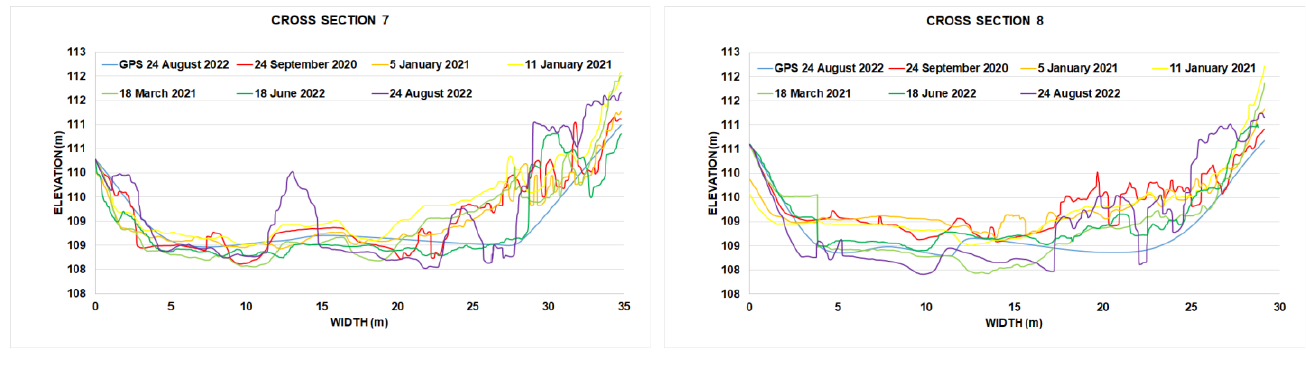
Figure 8. The produced profile of the cross-sections developed by the six UAV flights and the GPS field survey for each cross-section: ( a ) cross-section 1, ( b ) cross-section 2, ( c ) cross-section 3, ( d ) cross-section 4, ( e ) cross-section 5, ( f ) cross-section 6, ( g ) cross-section 7, ( h ) cross-section 8.